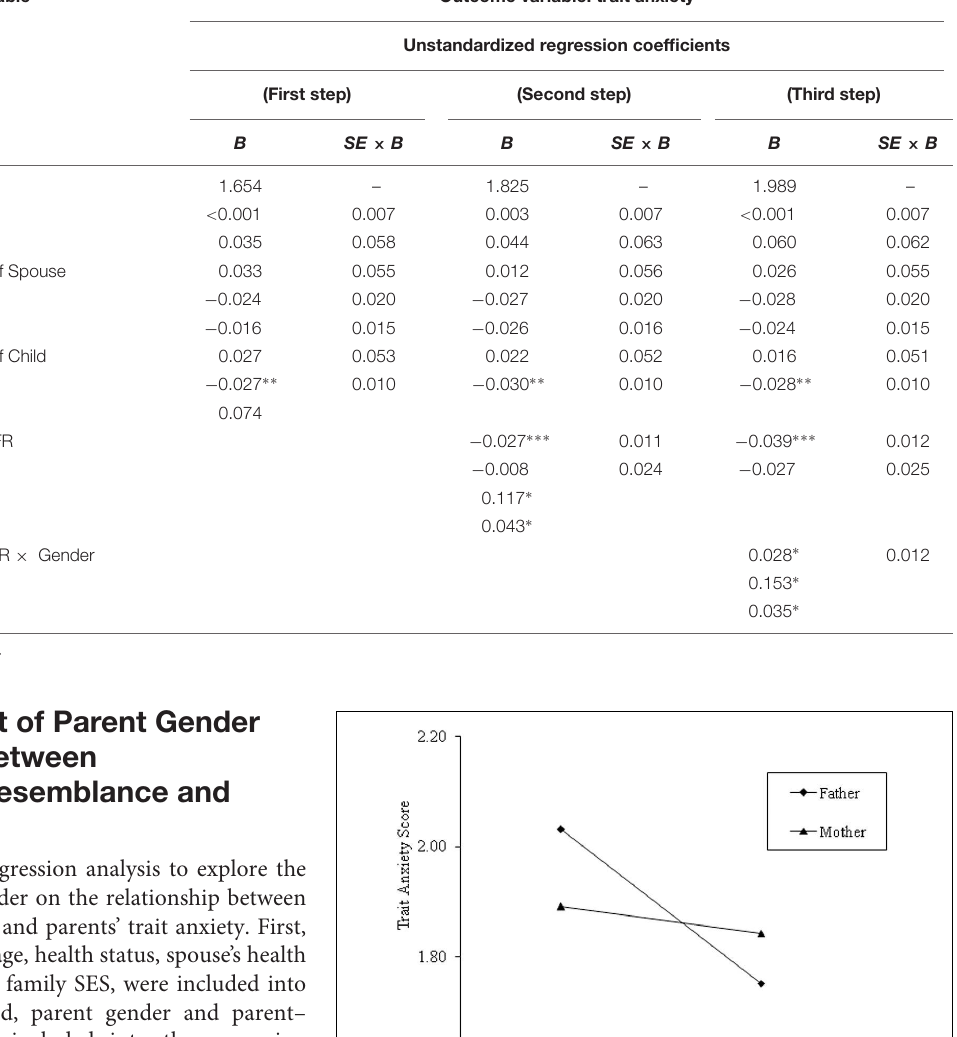
TABLE 1 | The effect of parent–child perceived facial resemblance (PFR) on parents’ trait anxiety. Predictor variable Outcome variable: trait anxiety